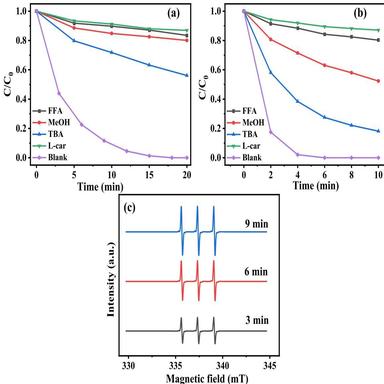
Effect of radical quenchers on PNP degradation in the Cu3Ni/NC-600-one year catalyst + PMS system (a), and CuO-NiO/NC-600 catalyst + PMS system (b), and ESR spectra of different reactive oxygen species in CuO-NiO/PMS system trapped by 150 mM TEMP in aqueous solution (c). Experimental conditions: = 0.05 g/L, = 0.05 g/L, = 2.6 mM, = 12.5 mg/L, initial pH = 9, temperature = 25 ℃, = = 26 mM, = = 1.3 M.